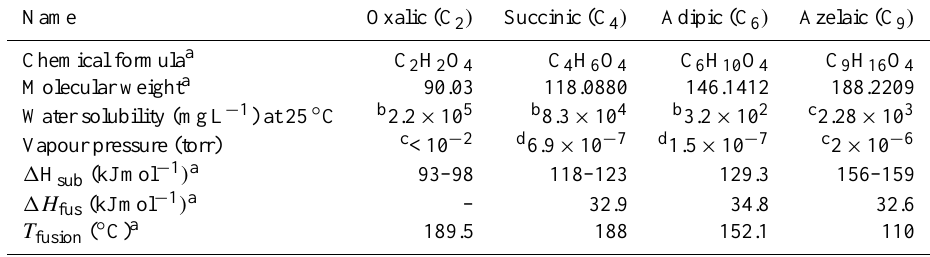
Table 1. Thermodynamic properties of the compounds used in experiments at ambient pressure. In particular, the oxalic and succinic acids have a high solubility in water, and are the most present in submicron terrestrial aerosol.